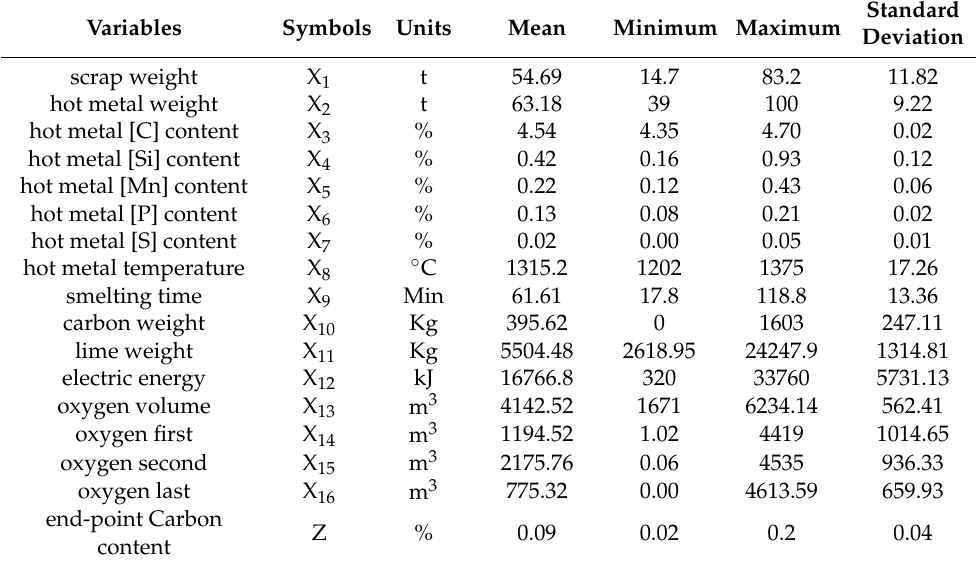
Table 1. Production data